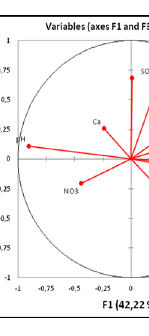
Fig. 8 Analysis within the variables